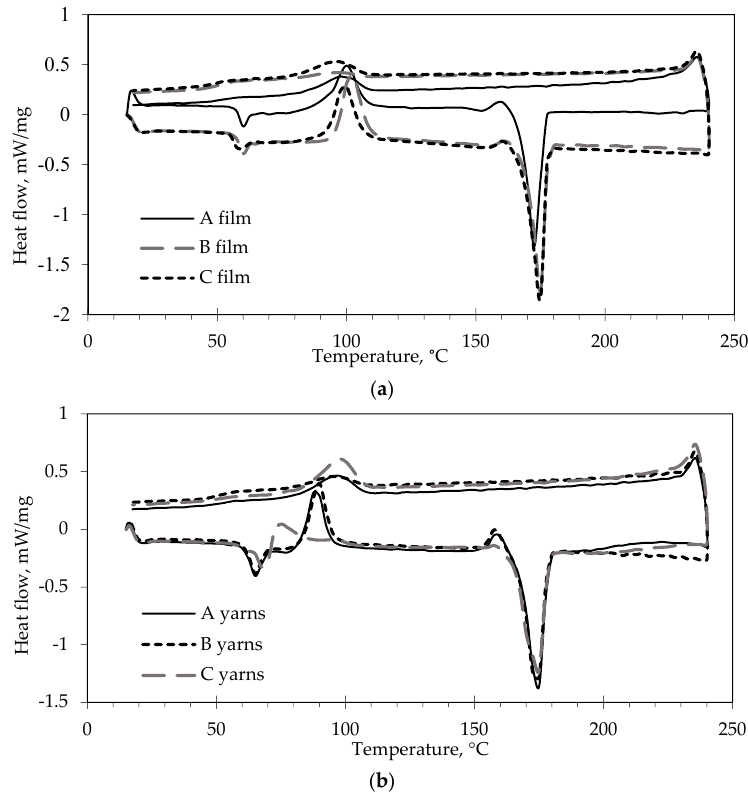
Figure 6. DSC thermograms analysis of ( a ) PLA films (A—pure PLA polymer; B—PLA polymer modified with ethanolic myrrh extract; C—PLA polymer modified with aqueous myrrh extract) and ( b ) PLA multifilament yarn (from A—pure PLA polymer; B—PLA polymer modified with ethanolic myrrh extract; C—PLA polymer modified with aqueous myrrh extract).